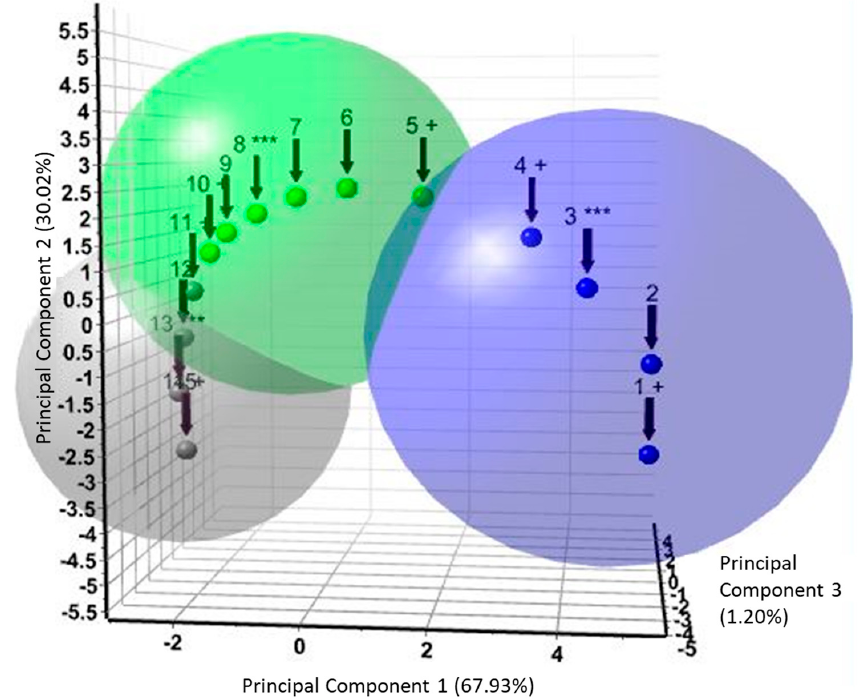
Figure 6. Clustering of petalite–quartz mixtures (three clusters with differing lithium contents). *** most representative sample of cluster, + are the most different ones in the clusters.